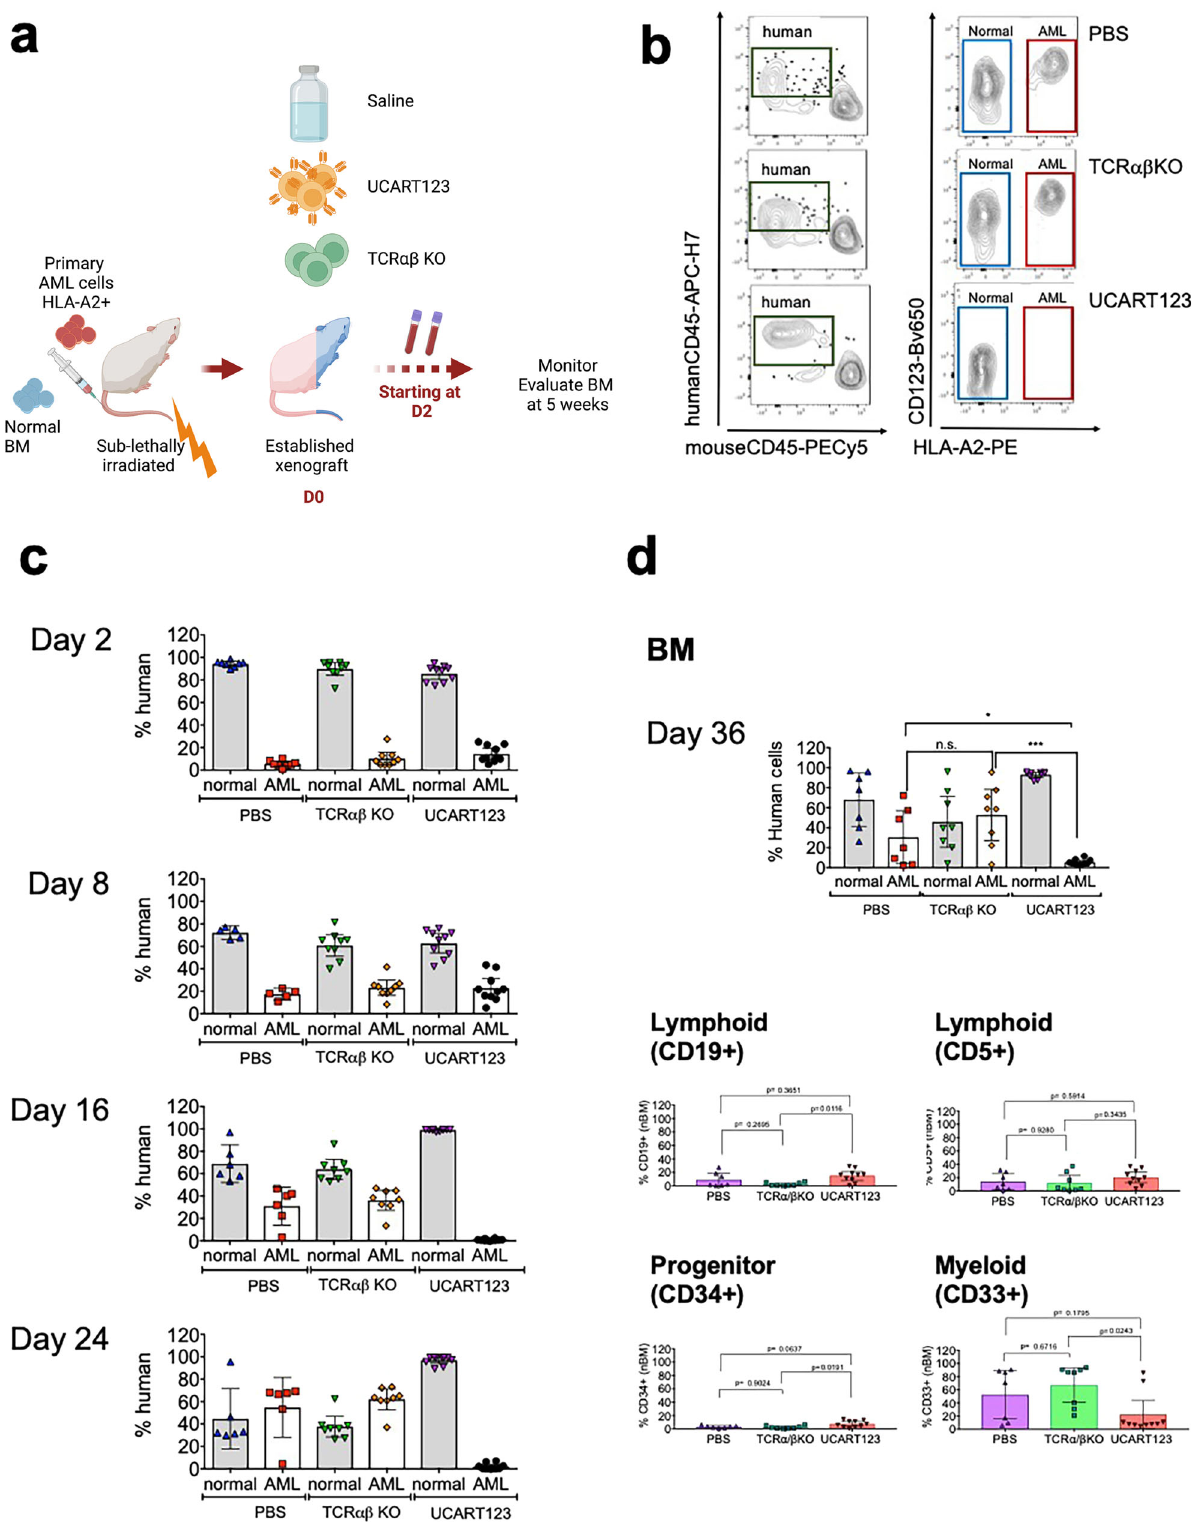
Cell viability assay . UCART123 cells were co-cultured at different E:T ratios (5:1, 1:1, and 0.5:1) with the different target cell populations (AML, CB, BM, or AML + CB co-cultures). When CB or AML cells were tested individually with UCART123, the target cells were stained with CFSE. For competitive cytotoxicity assays between CB and AML cells, CB and AML cells were stained with CFSE and CTV respectively when co-cultured together. After co-culturing primary AML cells and cell lines with UCART123 for 24 h, cell viabilities were measured